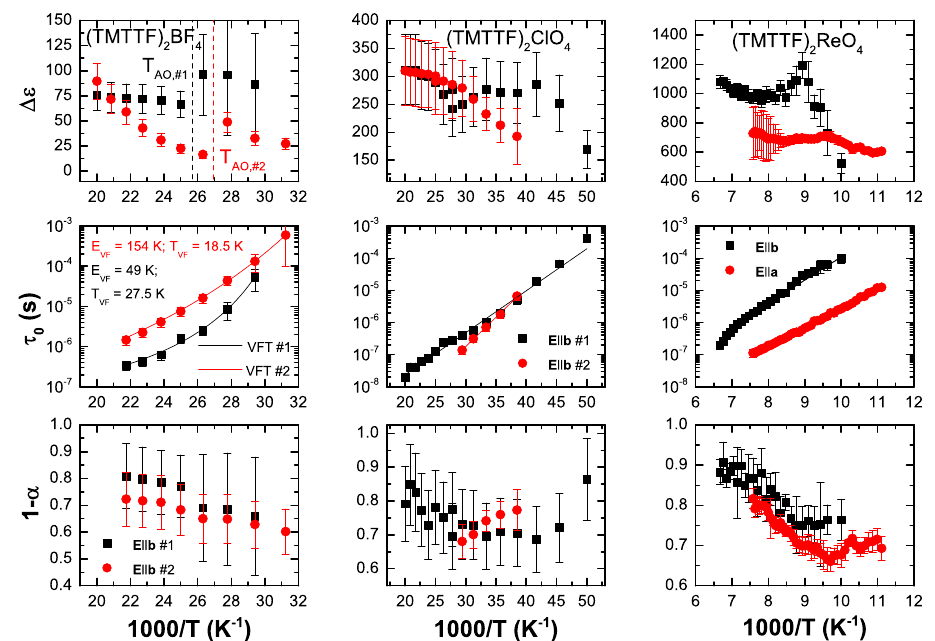
Figure 20. Temperature dependence of the parameters used to fit the dielectric spectra of (TMTTF) 2 BF 4 , (TMTTF) 2 ClO 4 and (TMTTF) 2 ReO 4 by the Cole-Cole model (1). The upper row shows the Arrhenius plots of the dielectric strength ∆ (cid:101) , followed by the relaxation time τ 0 and the broadening parameter ( 1 − α ) in the lower row. For X = BF 4 and ClO 4 the data on two crystals each (indicated by black and red symbols) are taken for E (cid:107) b (cid:48) . For X = ReO 4 we show data measured along the a and b (cid:48) -directions. Most important, in (TMTTF) 2 ClO 4 and (TMTTF) 2 ReO 4 the relaxation time τ 0 exhibits an activated behavior; the obtained activation energies resembles the gap previously measured in dc transport [4]. For (TMTTF) 2 BF 4 , τ 0 ( T ) increases with decreasing T in a fashion best described by the empirical Vogel-Fulcher-Tammann